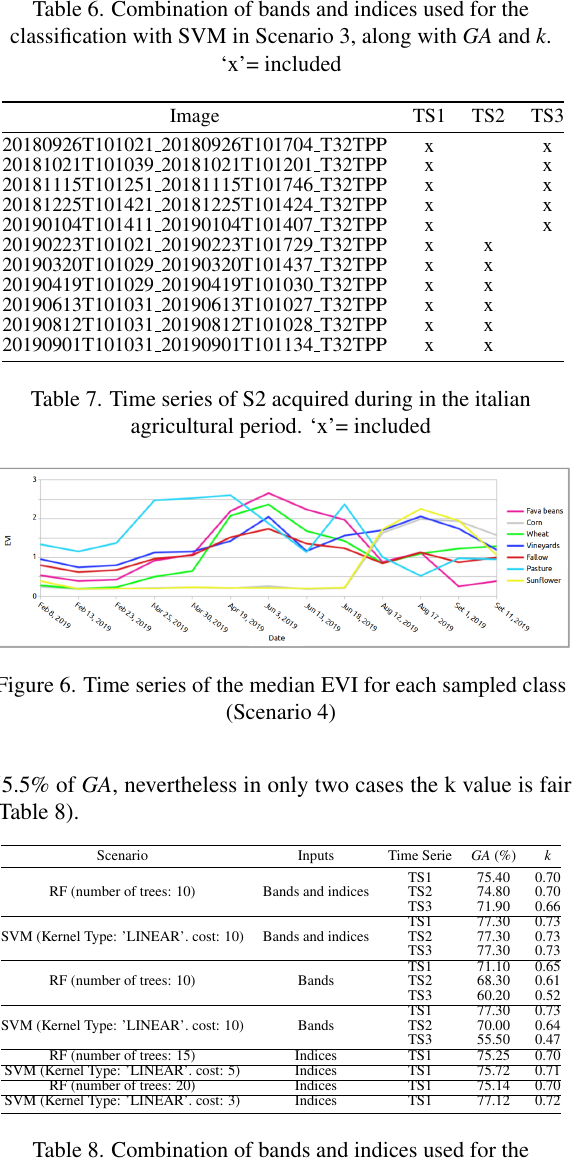
Table 8. Combination of bands and indices used for the classification with SVM in Scenario 4, along with GA and